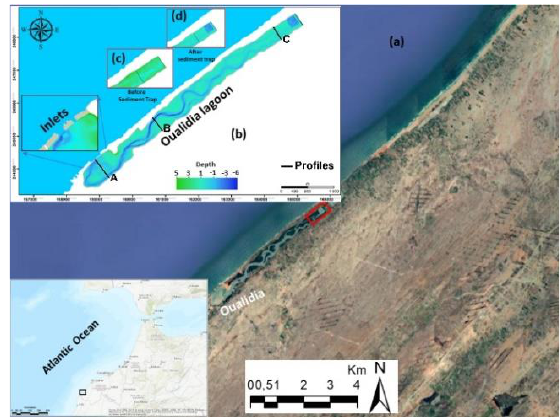
Figure 1. (a) Overview of the study area (Oualidia lagoon). The red box indicates the area of the sediment trap. (b) Bathymetry of the Oualidia lagoon. The red boxes show the state of the bathymetry before (c) and after (d) the sediment trap